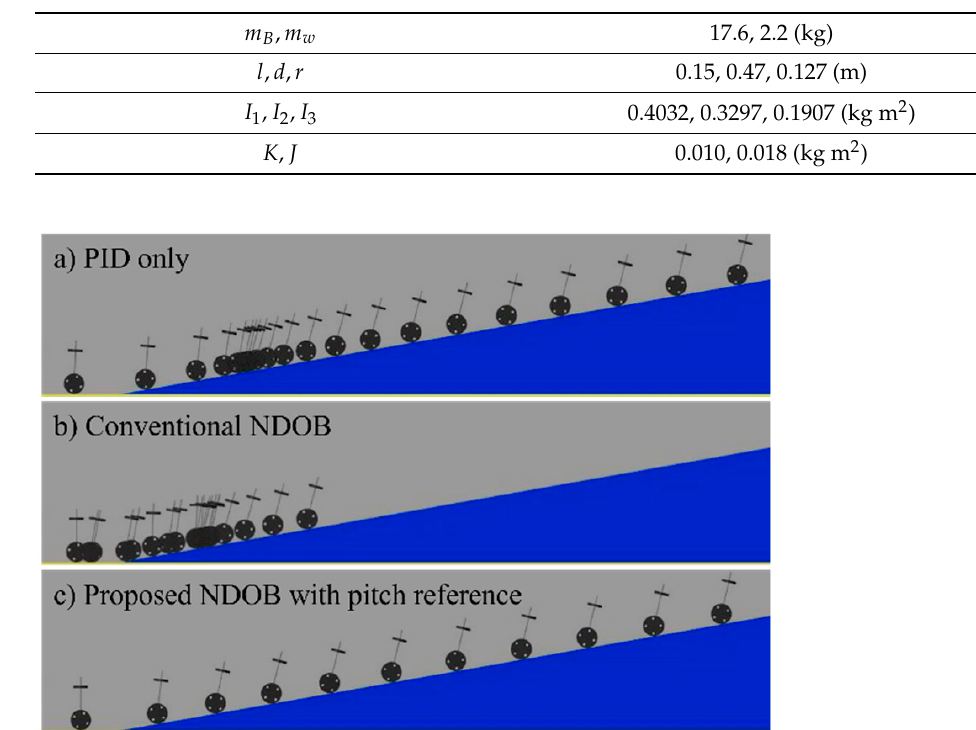
Table 2. Dimensions of TWIP robot.